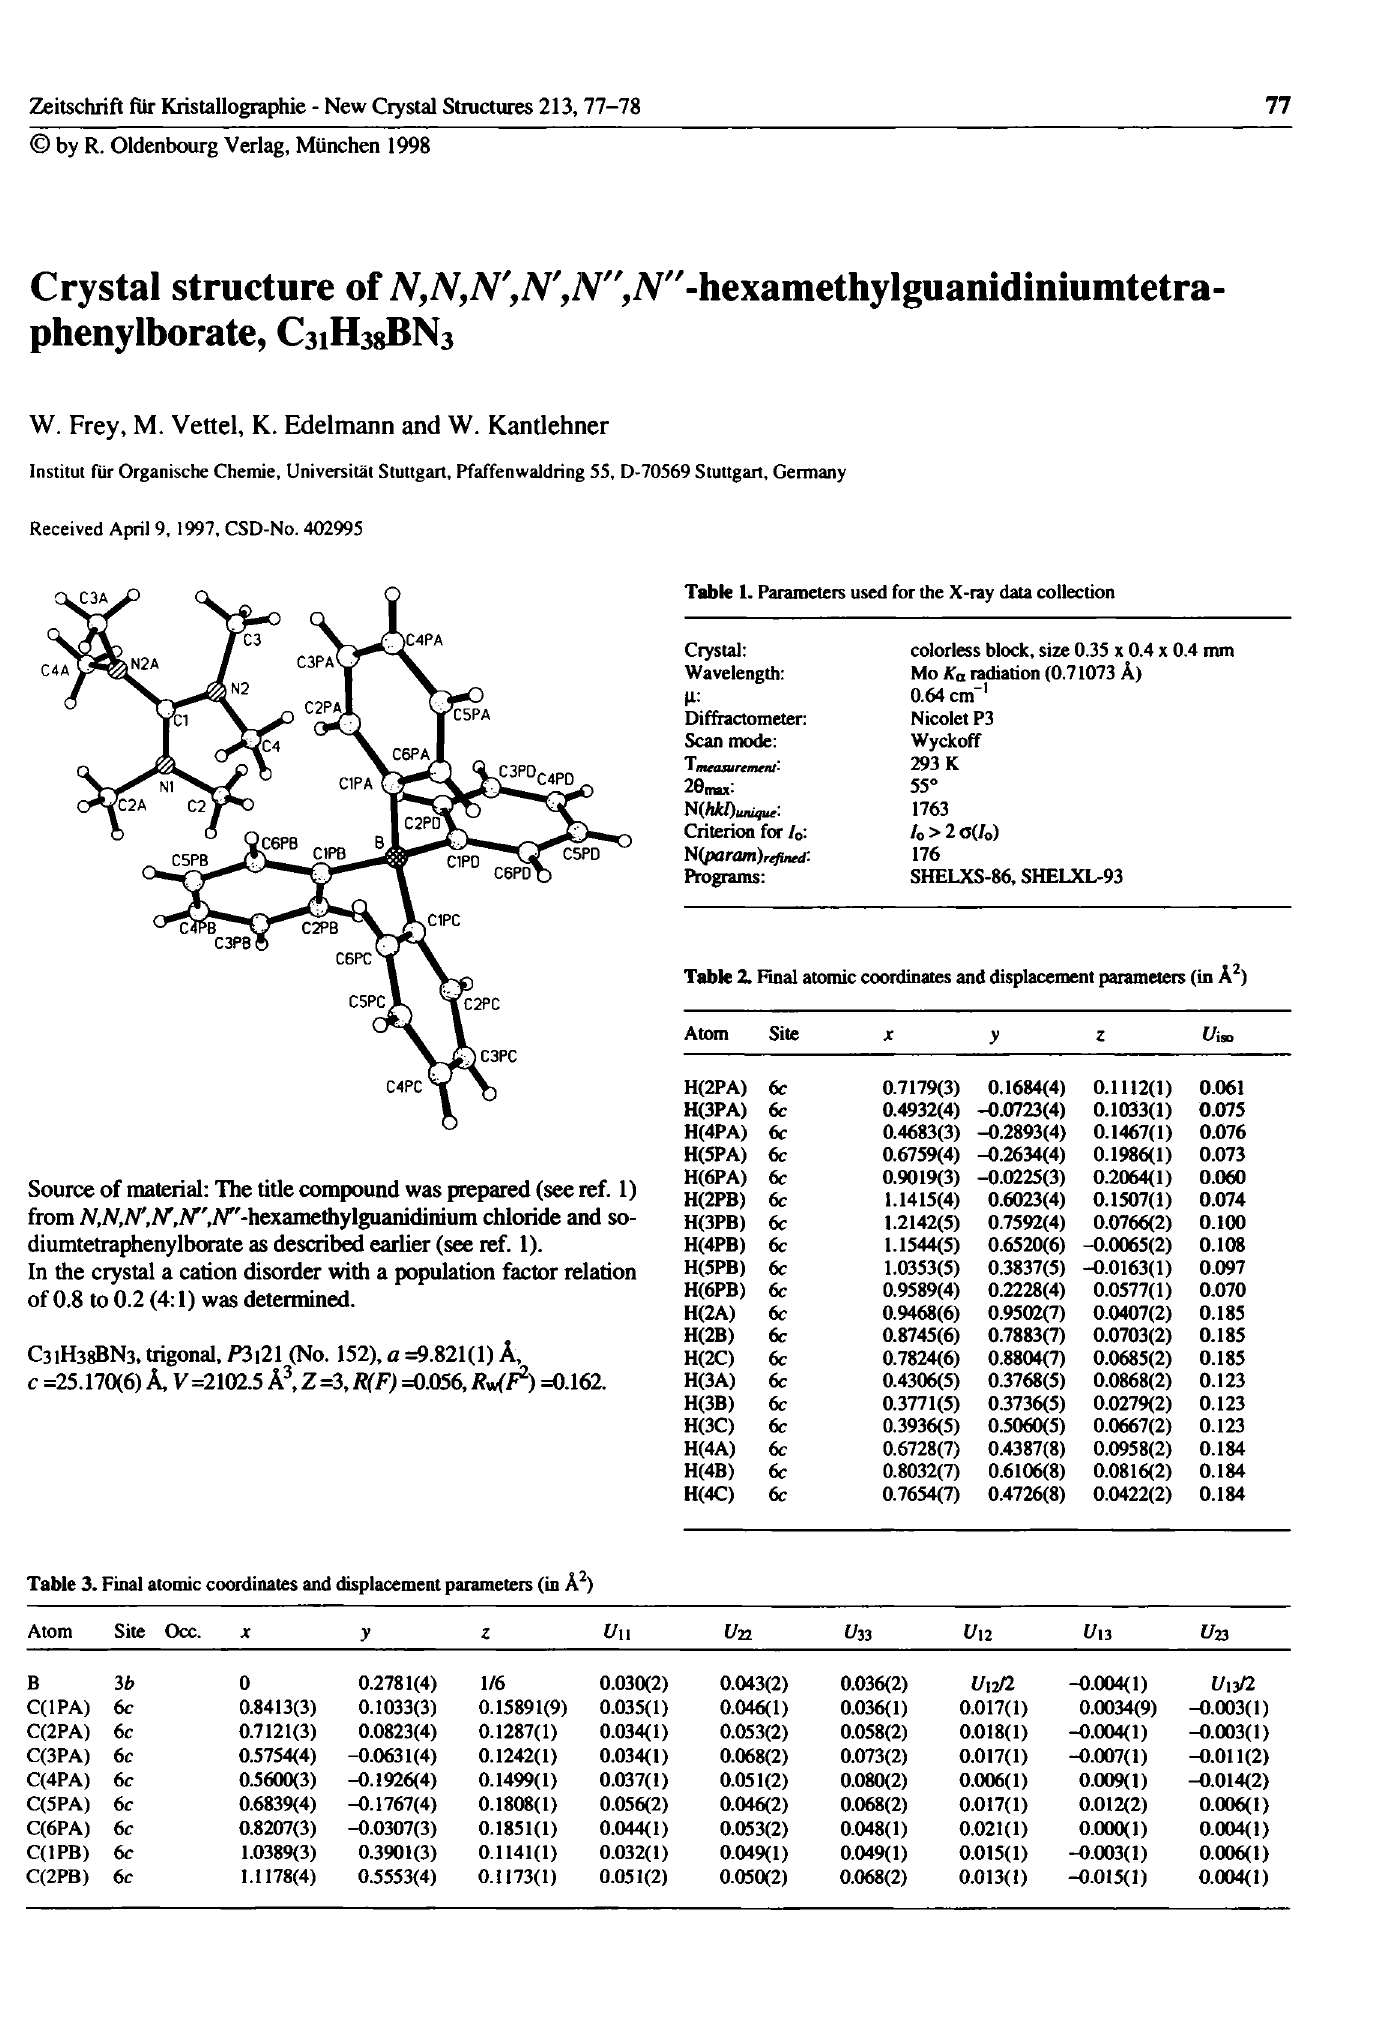
Table 3. Final atomic coordinates and displacement parameters (in Â^) Atom Site